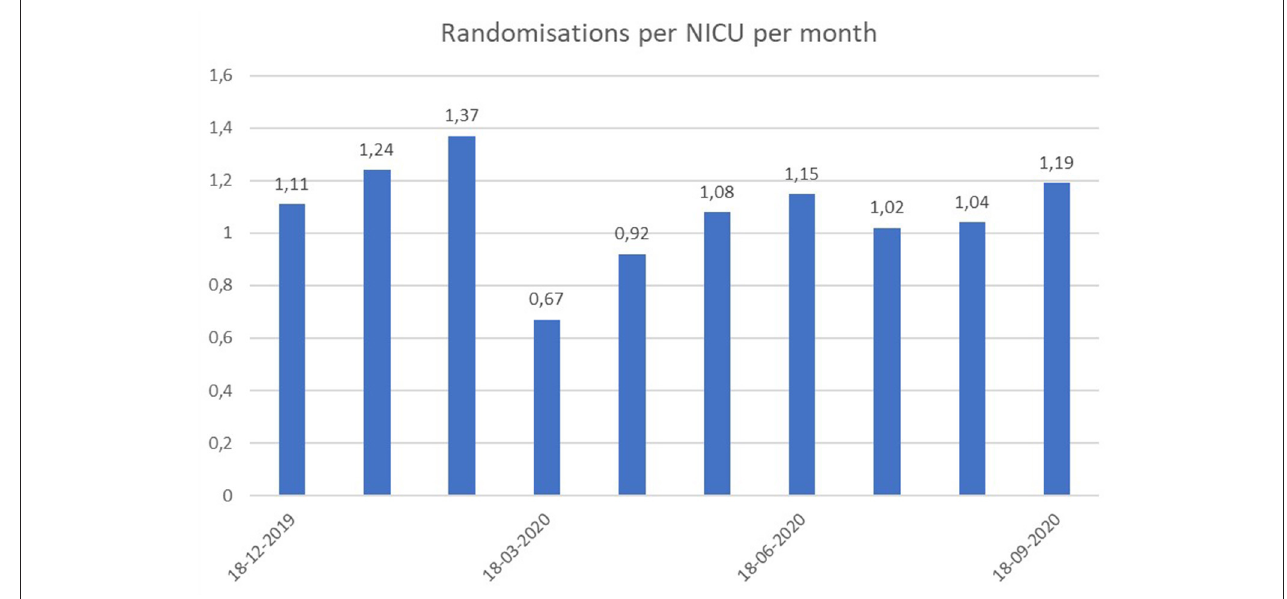
FIGURE 1 | Number of randomisations per month within each NICU actively randomizing infants in the SafeBoosC-III trial during the last 9